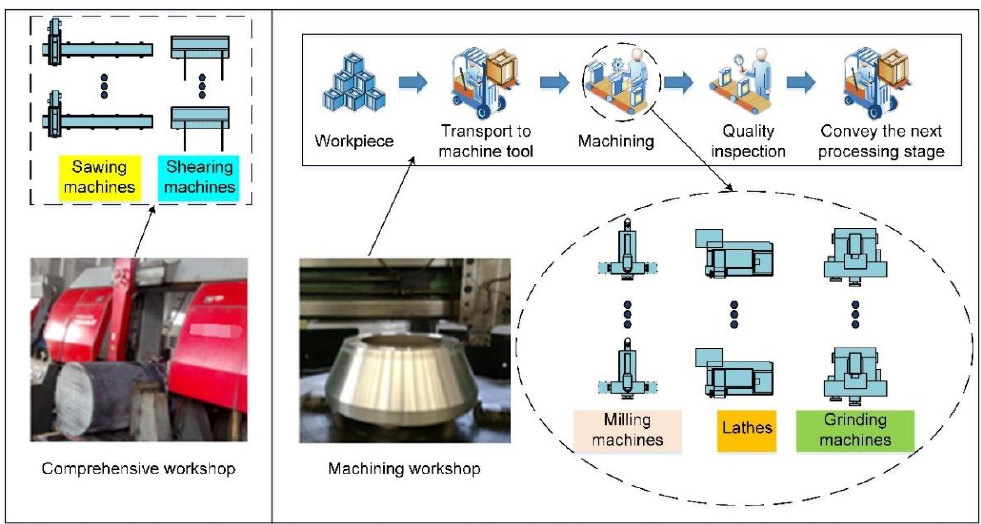
Figure 4. Comprehensive workshop and machining workshop.